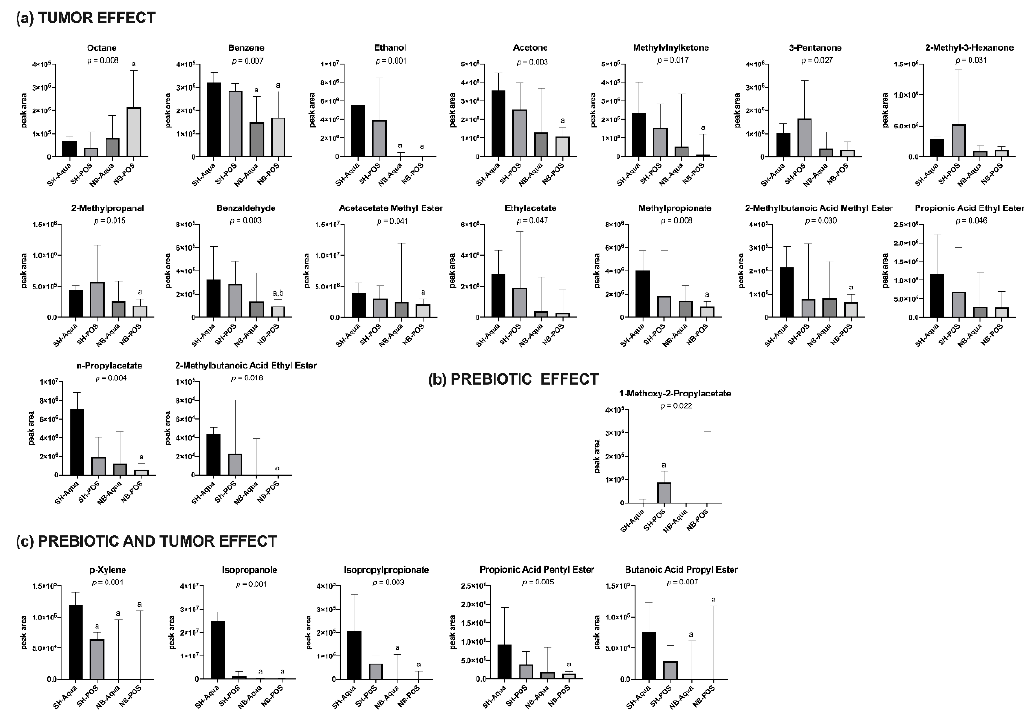
Figure 5. Fecal volatile organic compound (VOC) profiles of the different groups split into ( a ) tumor effect, ( b ) prebiotic effect, and ( c ) prebiotic and tumor effect. NB—neuroblastoma; SH—sham; POS—prebiotic oligosaccharide; a— p < 0.05 vs. SH-Aqua; b— p < 0.05 vs. SH-POS.